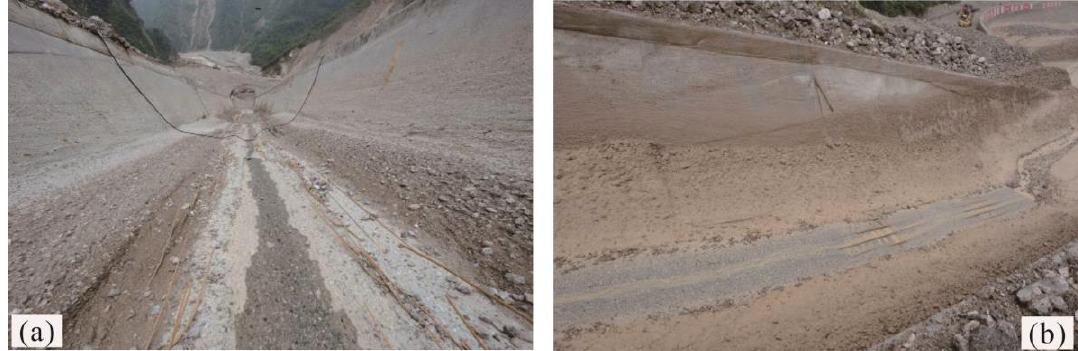
Figure 13. Abrasion at the bottom of the upstream and downstream sections of the channel. ( a ) The steel bar at the bottom of the section B 1 was almost destroyed; ( b ) the section B 3 was only partially exposed.